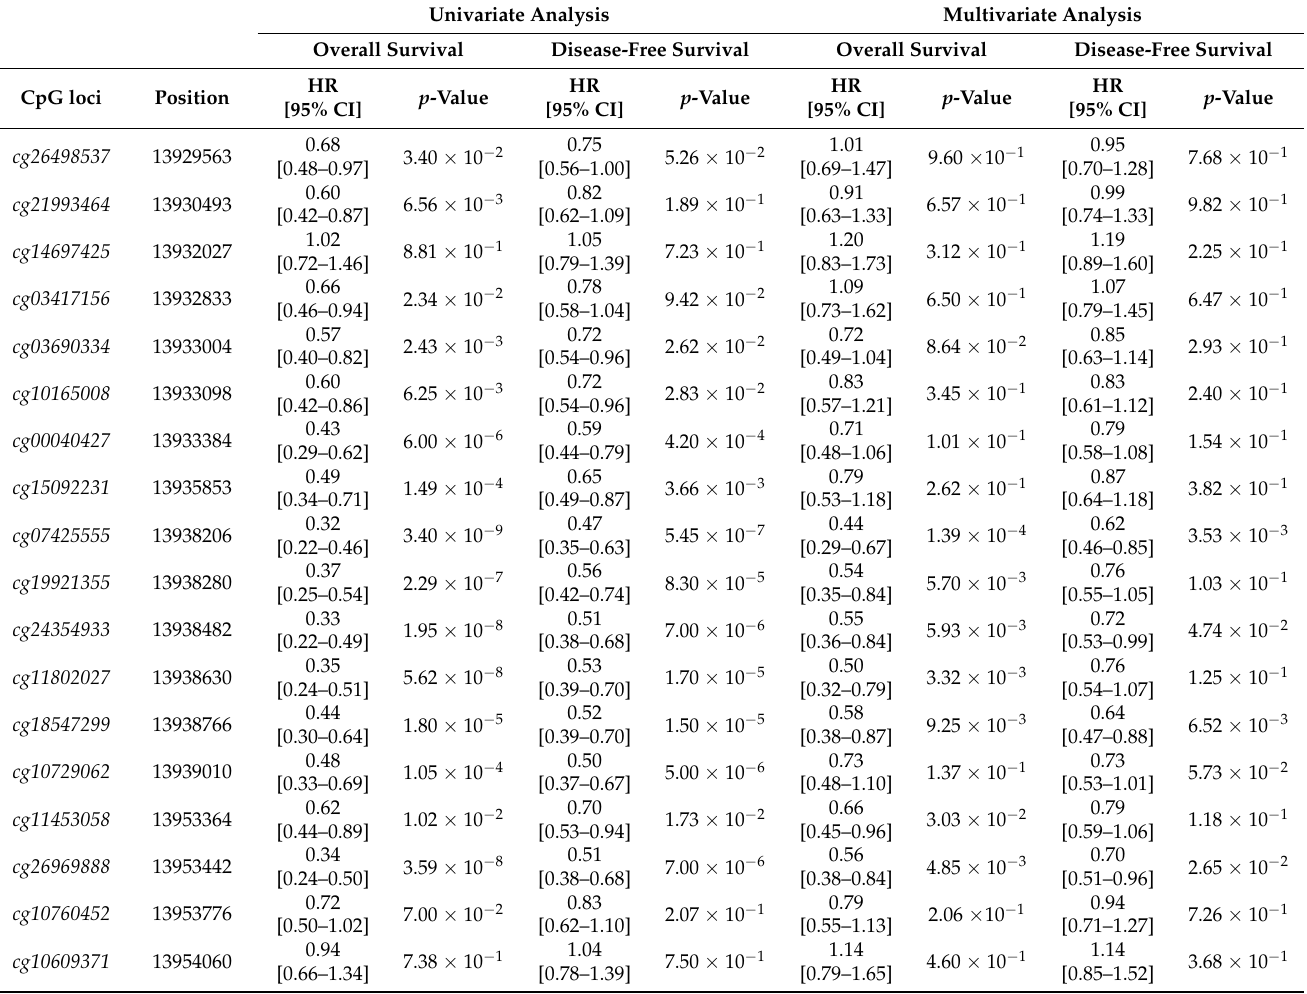
Table 1. Univariate and multivariate survival analysis based on PODNL1 CpG methylation high/low subgroups. Univariate Analysis Multivariate Analysis Overall Survival Disease-Free Survival Overall Survival Disease-Free